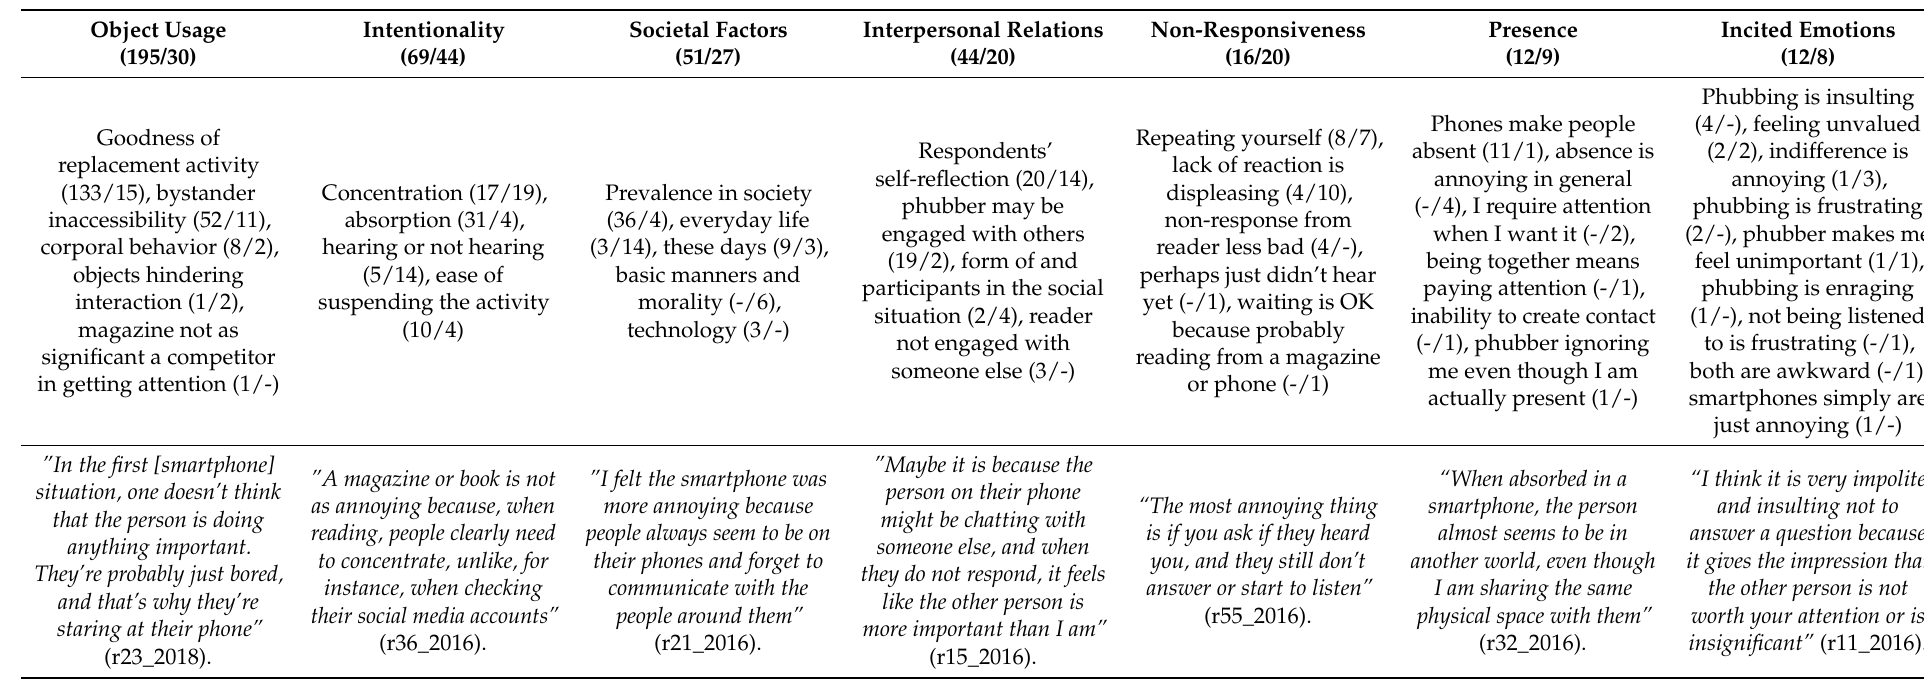
Table 4. Main themes, themes, and data